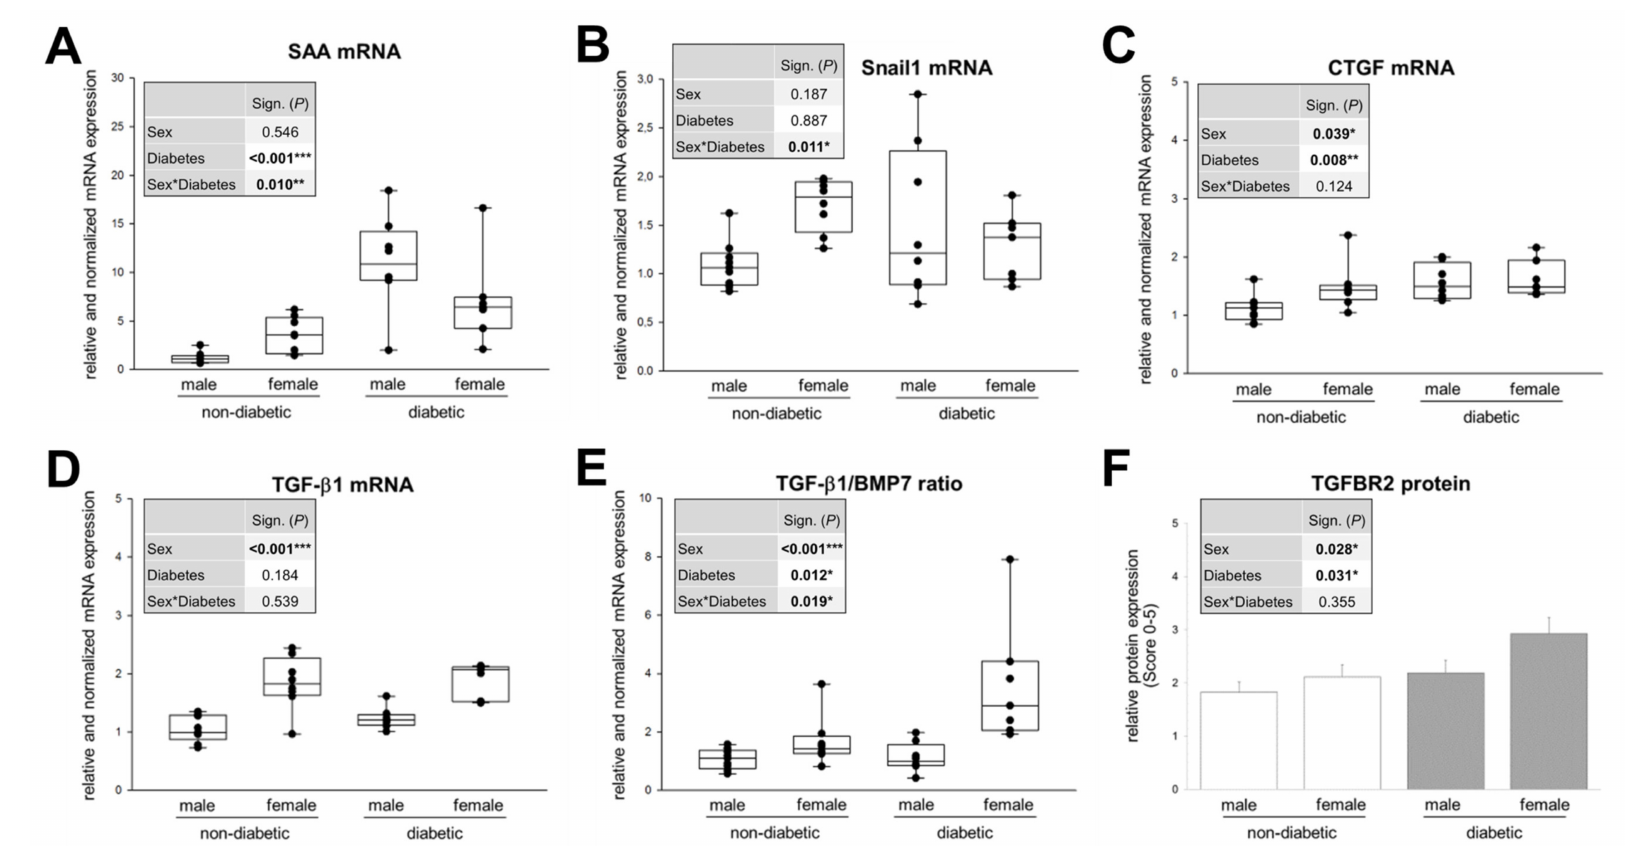
Figure 4. Expression of molecular markers of TIF in kidney cortex of non-diabetic and diabetic mice. ( A ) Real-time PCR analysis of SAA (serum amyloid A) mRNA. ( B ) Real-time PCR analysis of Snail1 mRNA. ( C ) Real-time PCR analysis of CTGF (connective tissue growth factor) mRNA. ( D ) Real-time PCR analysis of TGF- β 1 mRNA. ( E ) Ratio of real-time PCR analysis of TGF- β 1 and BMP7 mRNA. ( A – E ) Each point on the graph represents an individual mouse ( n = 10 / 8 / 8 / 7). ( F ) Semi-quantitative analysis of the immunohistochemical staining of TGF- β 1 receptor 2 (TGFBR2) ( n = 9 / 7 / 9 / 7 animals with 10 non-overlapping kidney areas). ( A–F ) The significances, shown in the table insert, were assessed using two-way ANOVA with sex (male or female) and diabetes (non-diabetic or diabetic) as the two factors. Sex, Diabetes: main e ff ect of sex / diabetes, respectively. Sex*Diabetes: interaction (determines whether the one main e ff ect depends on the level of the other main e ff ect). * P ≤ 0.05; ** P ≤ 0.01; *** P ≤